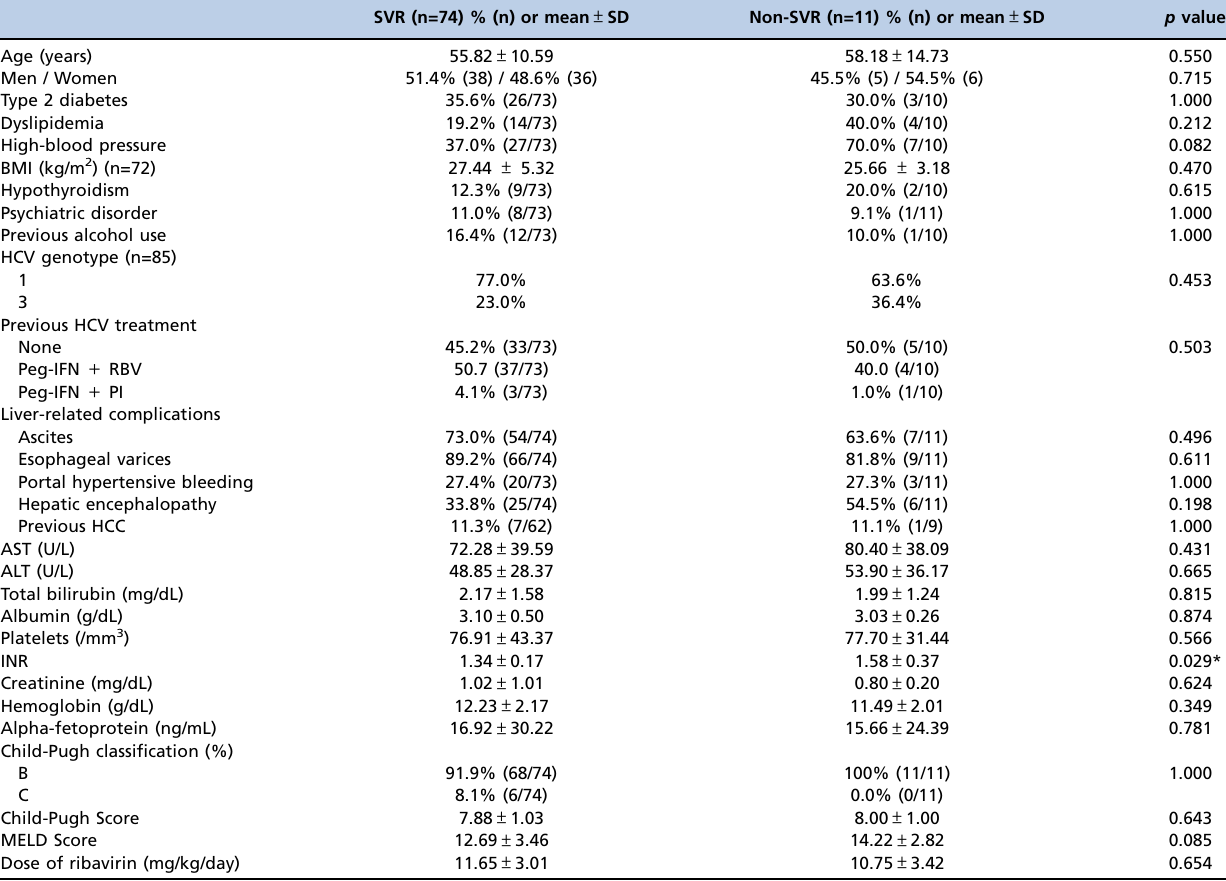
Table 3 - Variables associated with SVR by ITT analysis